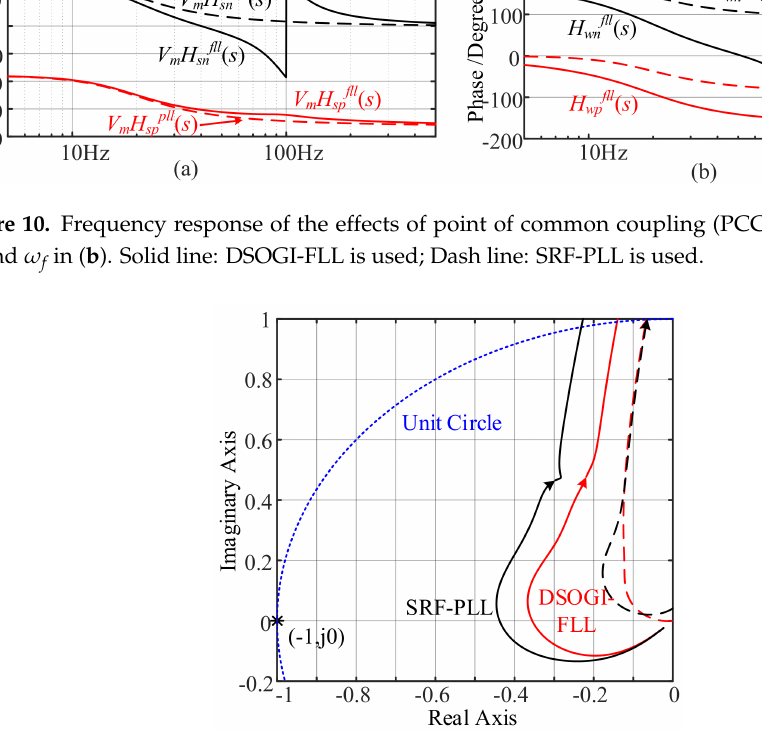
Figure 11. Nyquist curves of characteristic loci of L αβ using different PLLs. Black line: SRF-PLL; Red line: DSOGI-FLL is used. Solid line: λ 1 ( s ); Dash line: λ 2 ( s